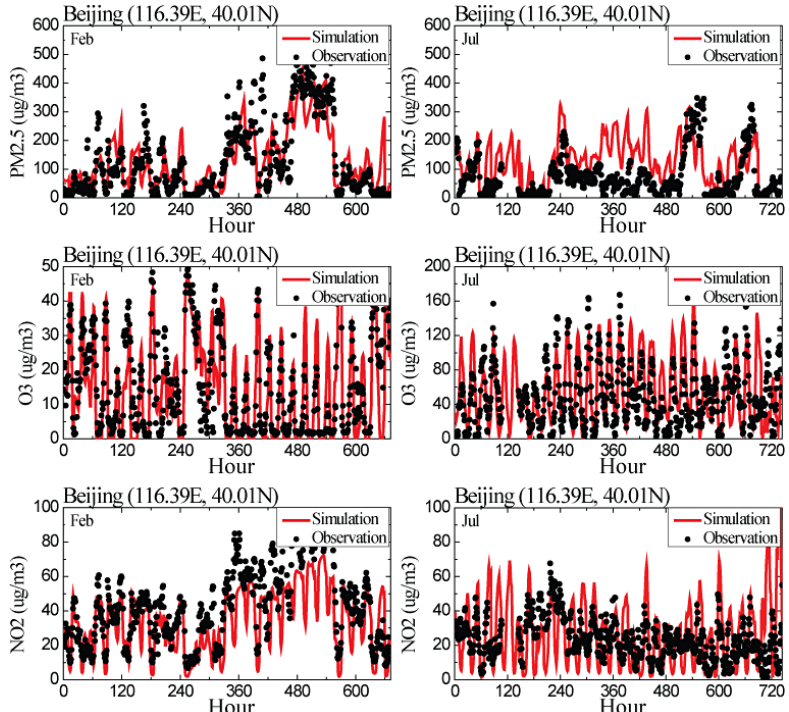
Figure 7. Observed (black circles) and modeled (red solid lines) hourly mass concentrations (µgm − 3 ) of PM 2 . 5 , O 3 , and NO 2 in February and July 2011 at